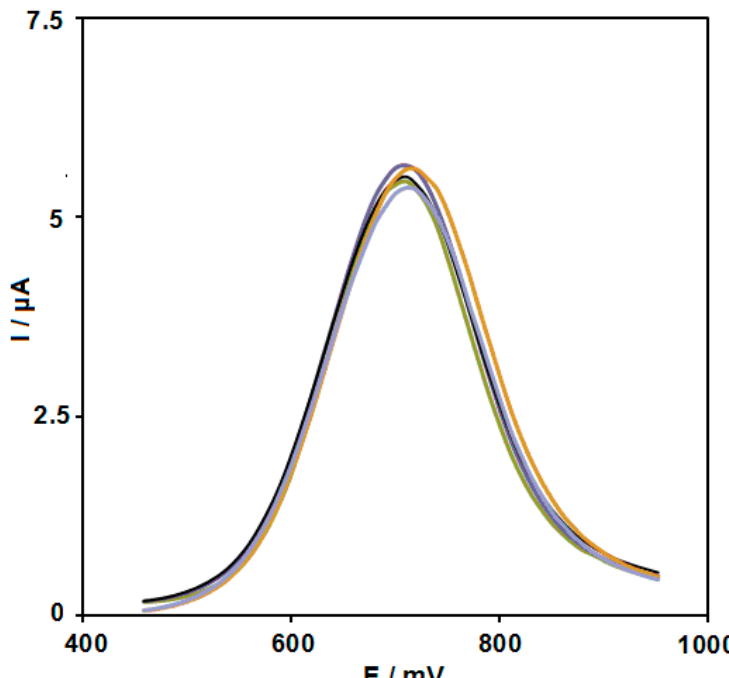
Figure 12. DPVs captured for the oxidation of 50.0 µ M sunset yellow contents on the five constructed NiCo 2 O 4 /SPGEs.